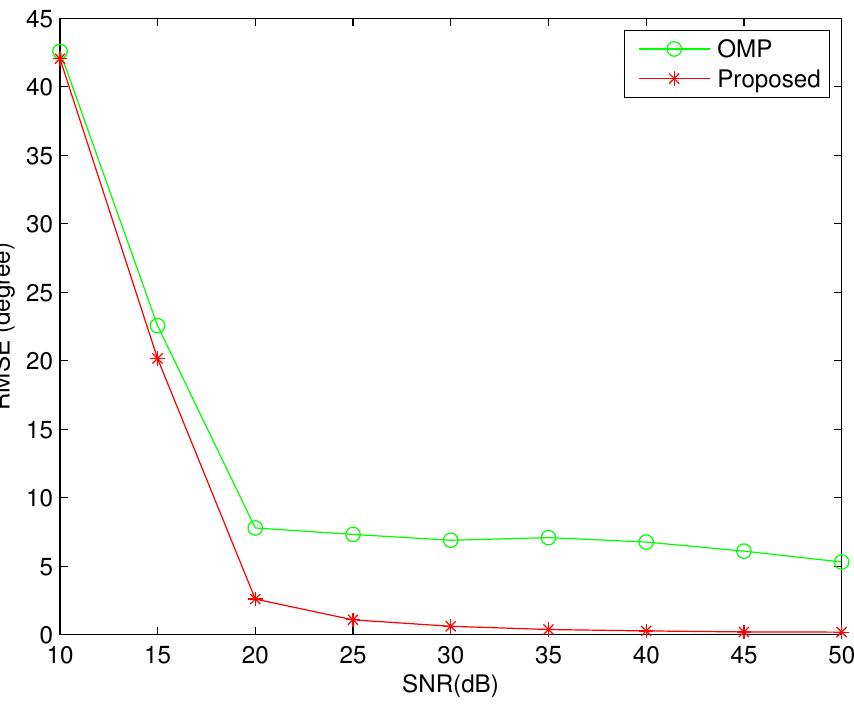
Figure 6. Root mean square error as a function of SNR . Four sources are assumed from the DOAs: {− 36 . 1 ◦ , 4 . 1 ◦ , 8 . 1 ◦ , 54 . 1 ◦ } . The minimal DOA difference is 4 ◦ , and the grid spacing is 0 . 1 ◦ . The curves were obtained by averaging the results of 100 independent simulation